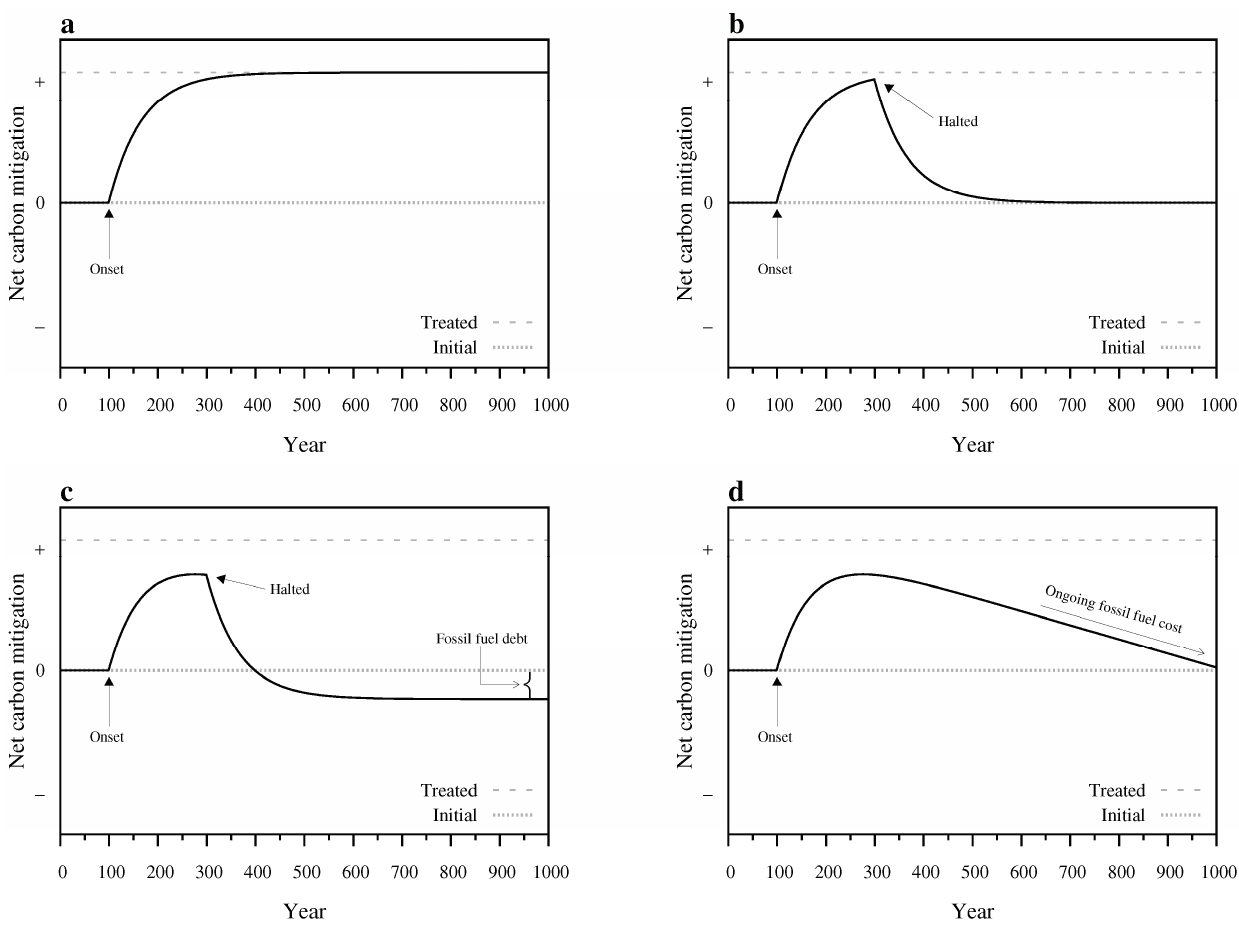
Figure 2. Net carbon mitigation from a treatment increasing forest carbon storage, based on realistic values for Canadian managed forests (CMF). The dotted gray line gives the initial landscape-level equilibrium carbon, whereas the dashed gray line gives the landscape-level equilibrium carbon with the treatment effect. ( a ) The treatment started in year 100 and was maintained perpetually. The results account for the forest landscape only; ( b ) The treatment started in year 100 and was halted in year 300. The results account for the forest landscape only; ( c ) The treatment started in year 100 and was halted in year 300. The results now also account for the fossil fuel emissions incurred; ( d ) The treatment started in year 100 and was maintained perpetually. The results now also account for the fossil fuel emissions incurred. Net carbon mitigation became negative in year